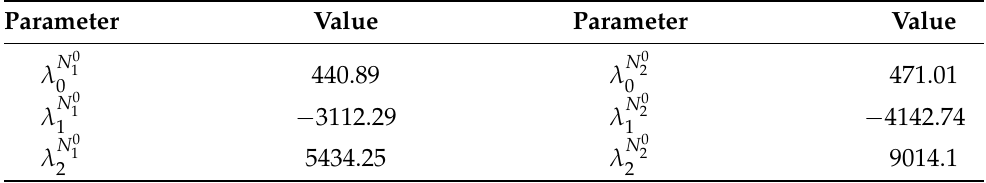
Table 2. Lagrange multipliers for the Principle of Maximum Entropy (PME) problem. Optimization has been performed by using the fsolve built-in algorithm in MATLAB ® and following the steps described in Section 3. Data used to perform the optimization is located in Table A1 (see Appendix